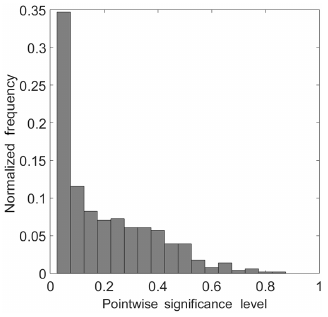
Figure 7. Distribution of persistence indices representing the life- times of patches. The distribution was obtained by generating 1000 wavelet power spectra of red-noise processes with lengths 500 and ρ = 0 . 5. Persistence indices equal to infinity are excluded from the